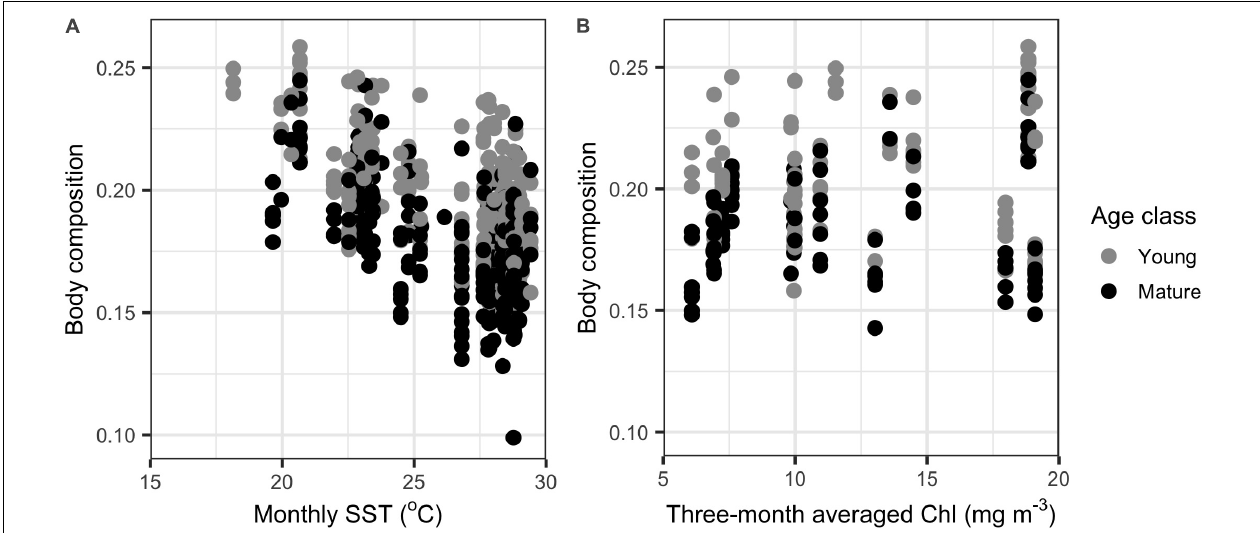
FIGURE 3 | Comparison of the relationship between monthly sea surface temperature (SST) and body composition ( n = 254 and n = 280 for young and mature individuals, respectively) (A) and CPUE and body composition ( n = 73 and n = 84 for young and mature individuals, respectively) (B) for common bottlenose dolphins ( Tursiops truncatus ) in Sarasota Bay. Monthly SST data were extracted from HadISST Average Sea Surface Temperature at 1 ◦ spatial resolution.